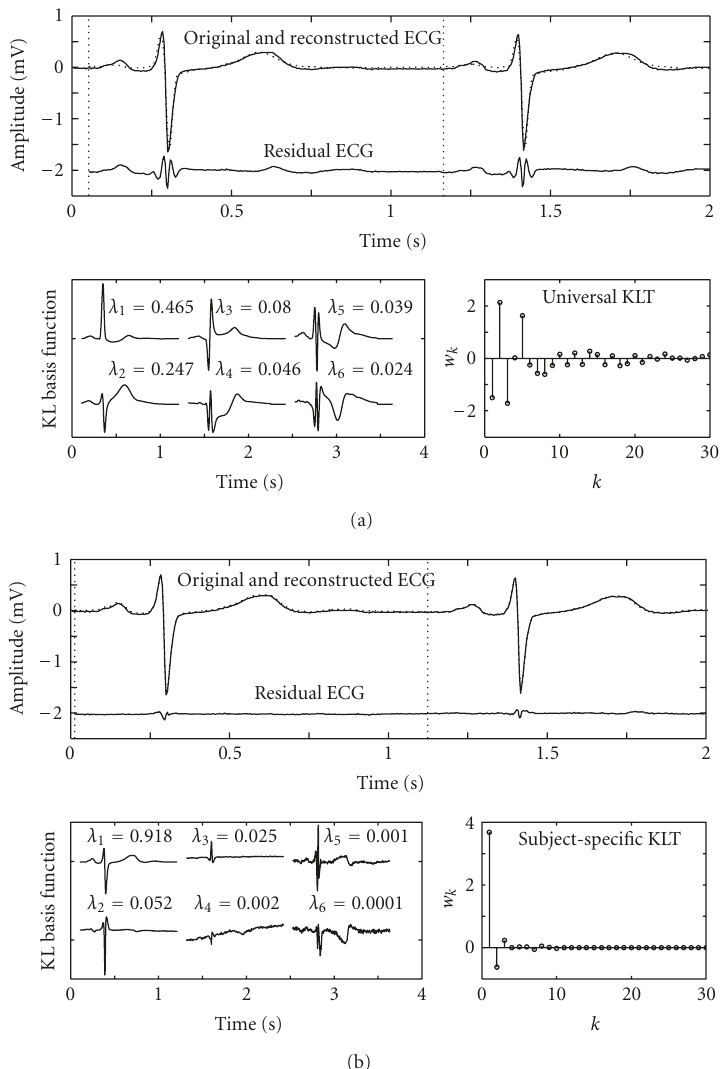
Figure 7: Transform-based data compression using the KL basis functions derived from either (a) a huge database including thousands of and associated eigenvalues λ k are presented as are the 30 ECGs from di ff erent subjects or (b) subject-specific data. The basis functions ϕ k largest coe ffi cients of the original ECG’s KLT. The ECGs are reconstructed with K = 8 and 2 for universal and subject-specific basis functions, respectively. For ease of interpretation, the residual ECG is plotted with a displacement of − 2